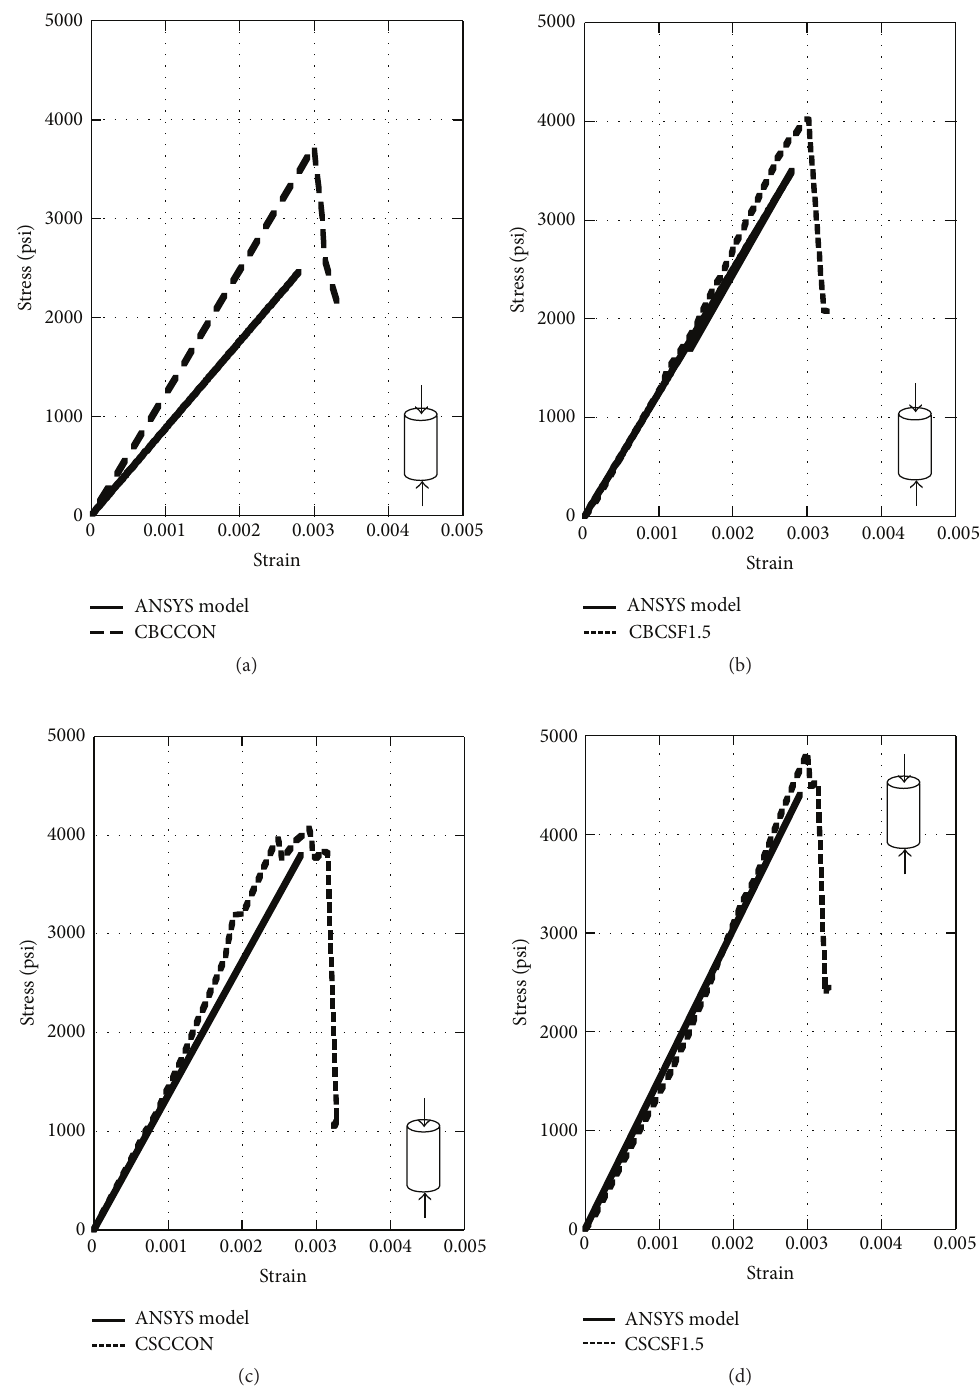
Figure 7: Evaluation of compressive stress-strain behavior from experimental tests and FE analyses: (a) brick concrete, (b) brick SFRC, (c) stone concrete, and (d) stone